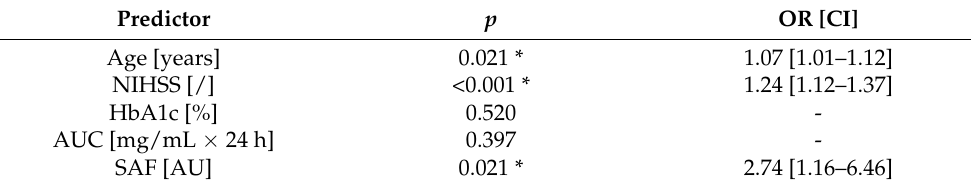
Table 2. Predictors of